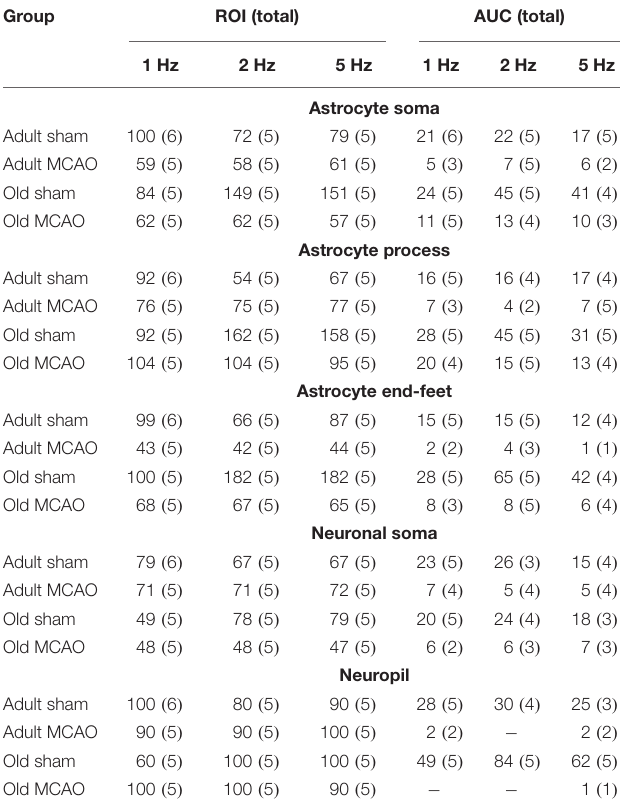
AUC (total) indicates the total number of responses, with the number of mice used for analysis of evoked Ca 2 + response size given in parentheses. ROI, regions of interest; AUC, area under the curve; MCAO, middle cerebral artery